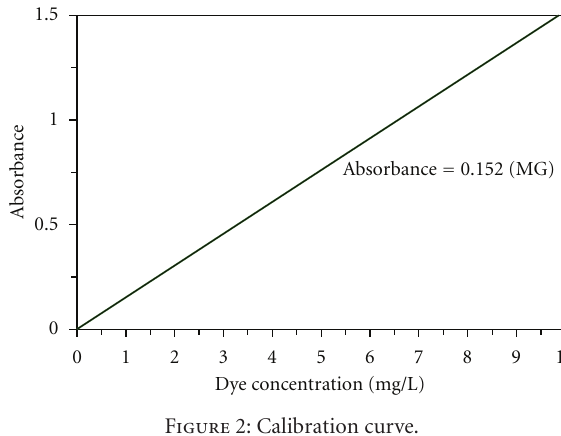
Figure 2: Calibration curve.